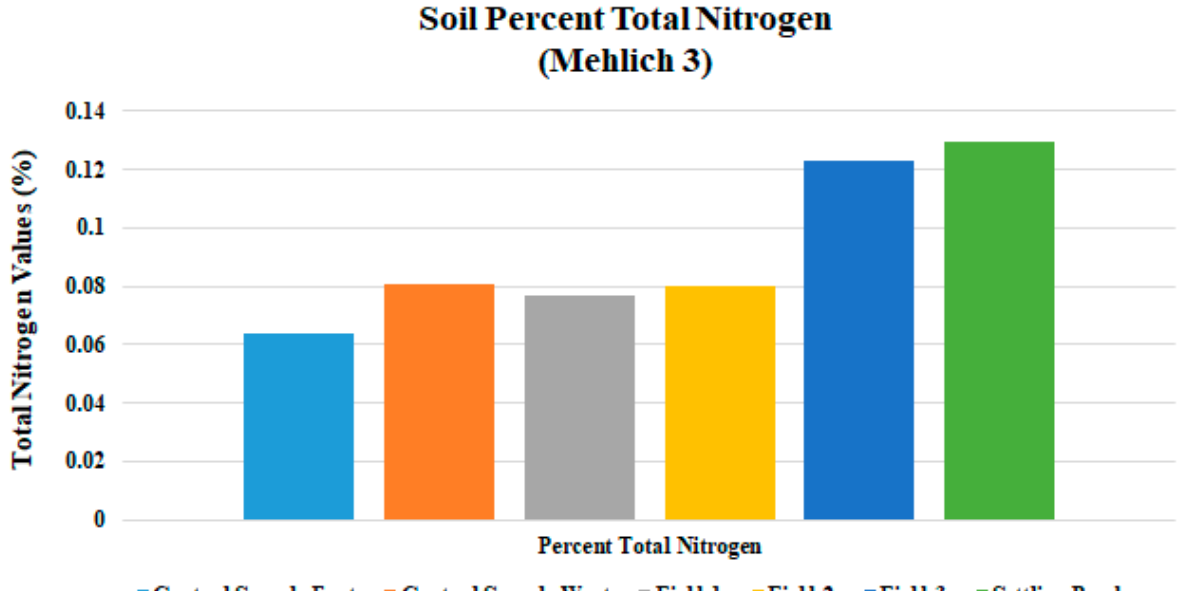
Figure 7. Mean total nitrogen levels for three fields and three sample ponds sampled during the study.